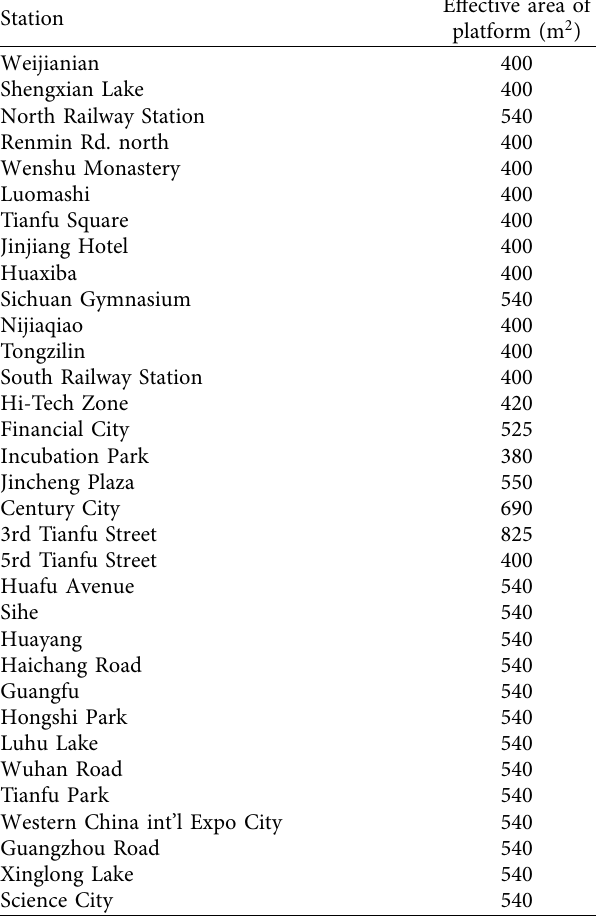
Table 5: Effective area of platforms on Line No. 1 Table 6: Predicted section flow in the third time interval (in part). Section